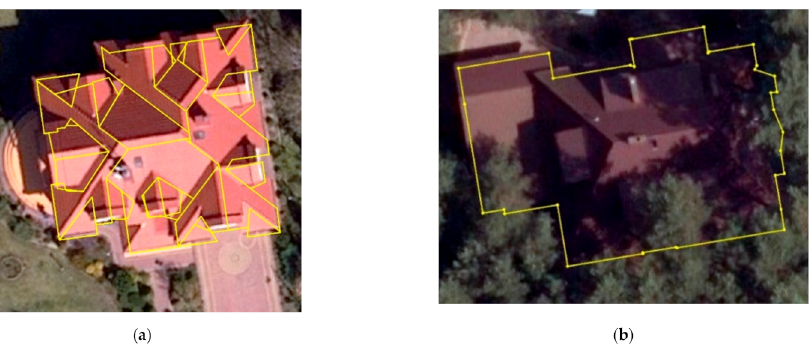
Figure 9. Buildings’ rooftop polygons hampered by: ( a ) complex, multi-slope roof; ( b ) vegetation cover.